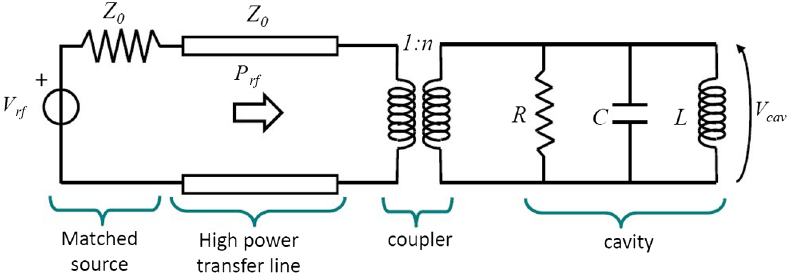
FIG. 27. Equivalent circuit of a cavity coupled to a rf